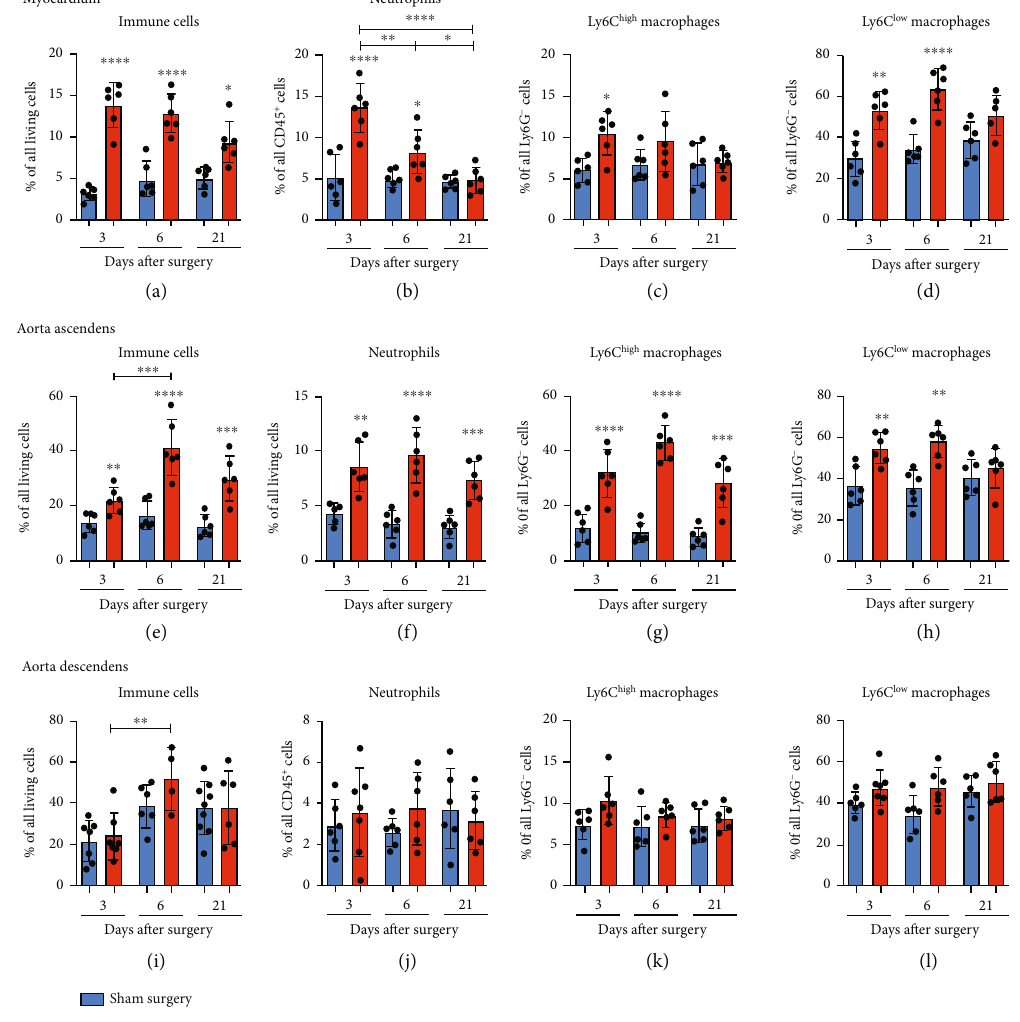
Figure 2: Innate immune response in the myocardium and the ascending and descending parts of the aorta. (a) – (l) The CD45 + immune cells, neutrophils, Ly6C low , and Ly6C high macrophages in the tissue of the LV, the aorta ascendens and descendens of the mice were quanti fi ed via fl ow cytometry. The particular cell subsets were de fi ned as follows: neutrophils as CD45 + F4/80 - Ly6G + and macrophages as CD45 + F4/80 + Ly6G - . Moreover, the Ly6C high and Ly6C low macrophages were further discriminated according to the respective Ly6C surface expression. ∗ The above individual columns indicate the signi fi cant di ff erences between the TAC and respective sham group; ∗ P < 0 : 05 , ∗∗ P < 0 : 01 , ∗∗∗ P < 0 : 001 , and ∗∗∗∗ P < 0 : 0001